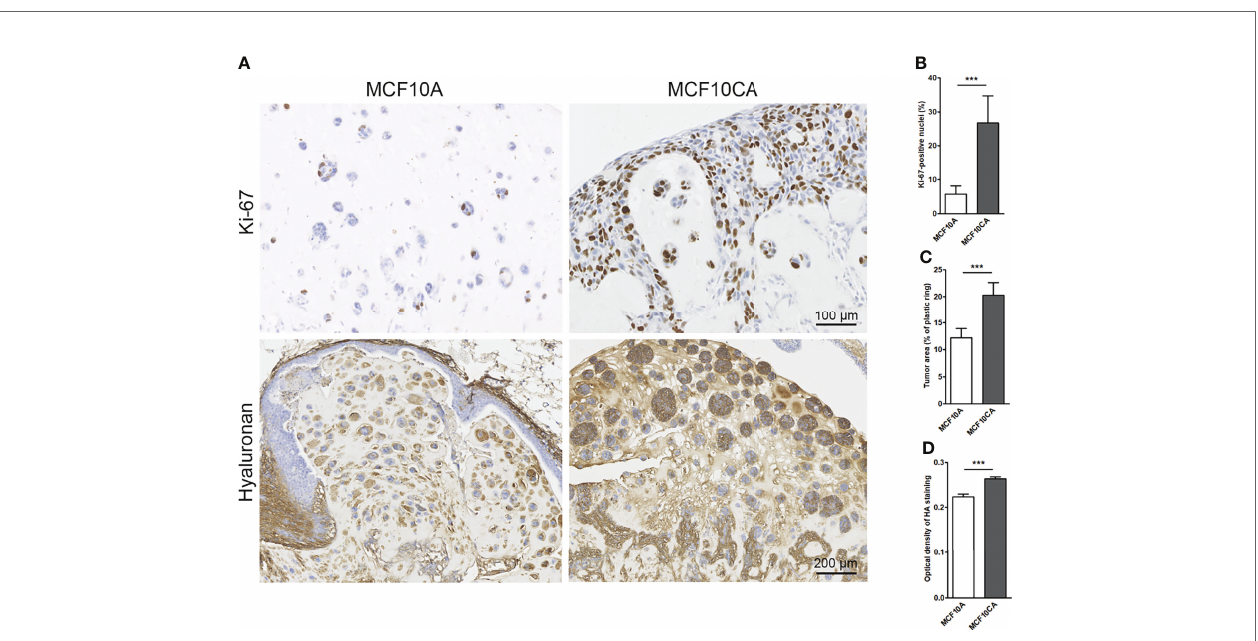
FIGURE 7 | MCF10CA cells have a higher proliferation index, and they form bigger tumors with higher hyaluronan content than MCF10A cells in CAM model. Representative images of Ki-67-stainings (brown) and hyaluronan stainings (brown) of MCF10A and MCF10CA tumor sections (A) The proportion of Ki-67-positive nuclei in both tumor groups is shown in (B) , the average tumor area is shown in (C) and optical density of HA staining visualized with DAB in (D) ; n = 8 in MCF10A and n = 10 in MCF10CA groups. **p < 0.001.